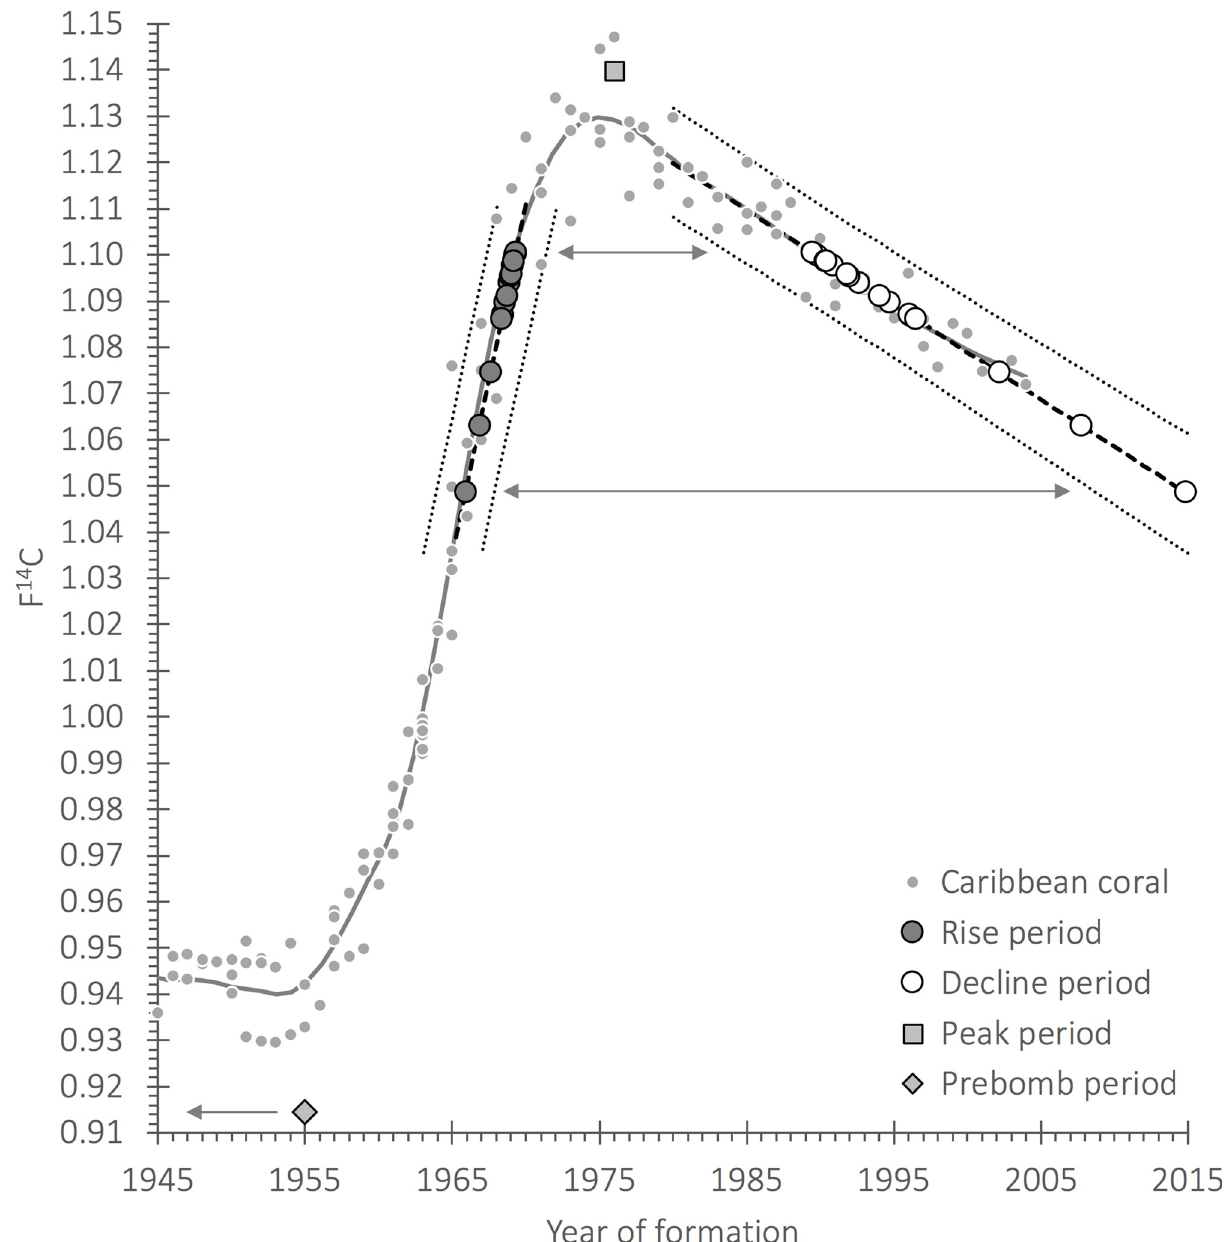
Fig 13. Plot of the radiocarbon ( 14 C) reference records available from hermatypic corals in the Caribbean Sea (Loess curve fit) with otolith 14 C data from sediment cores plotted on the correlated dates of formation. For most measurements the values crossed the regional 14 C reference curve with potential dates from the bomb 14 C rise or decline periods, with the exception of two samples (S1 Table). These fish were a short-lived species (gobies, Gobiidae) and posited to cover a negligible age ( < 2 years of growth). Dates of formation for rise and decline periods were from a simple linear regression of coral 14 C values that were coincident with the Loess curve for each time span. The outliers were one 14 C value that is centered on the peak at 1976 and the other is a pre-bomb otolith that was aged to median year of formation of 1550 AD (2 sigma = 1490–1640; CALIB Rev7.1.0 and see S2